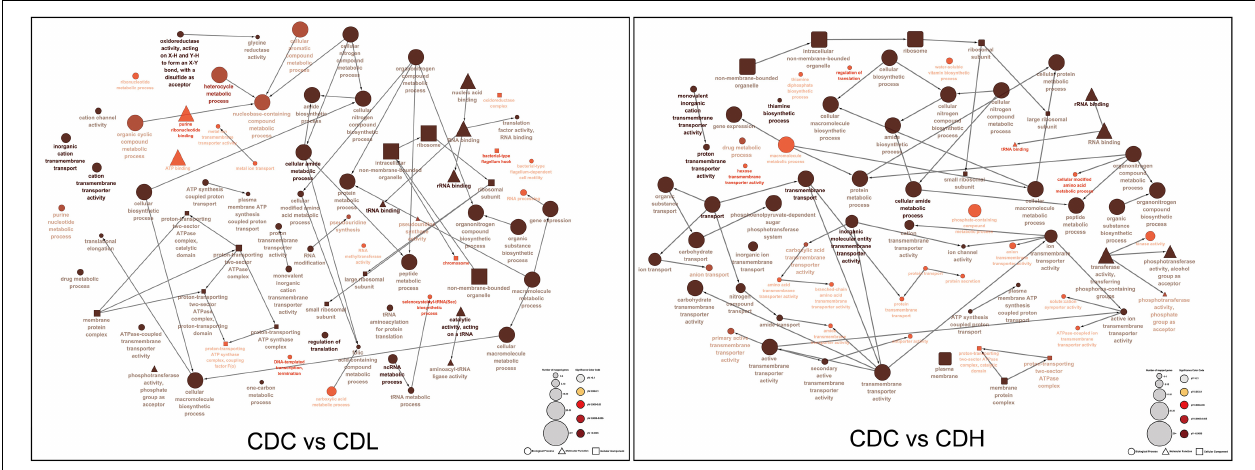
FIGURE 6 | ClueGO analysis of the top 10 GO terms in C. difficile . “ (cid:3) ” represent cellular component, “ (cid:77) ” represent molecular component, and “ ◦ ” represent biological